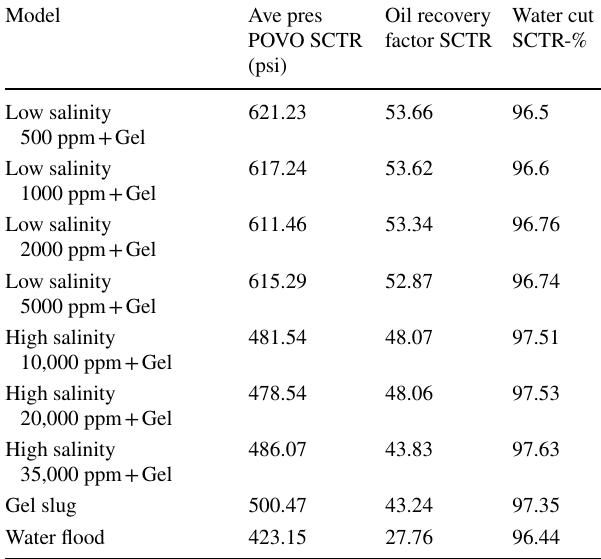
Table 3 Oil retention factors, average reservoir pressure and water cut percentage for the saline models Model